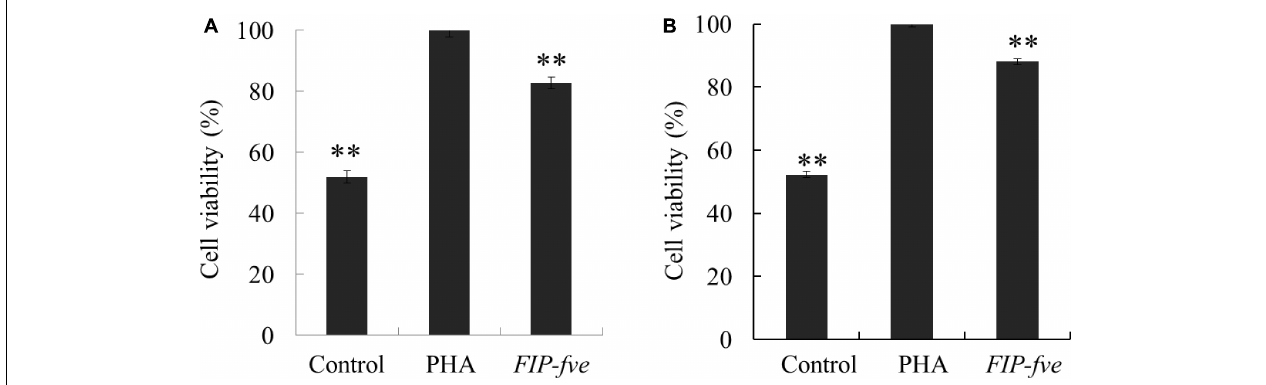
FIGURE 2 | FIP-fve treatment results in Jurkat E6-1 cells Proliferation. Jurkat E6-1 cells were treated with FIP-fve (100 µ g/ml) or PHA (5 µ g/ml) for 12 h (A) and 24 h (B) . Cell viability was assessed by Cell Counting kit-8 assay (CCK-8). PHA was used as a positive control. Values are mean ± SD, n = 3, ∗∗ p < 0.01.